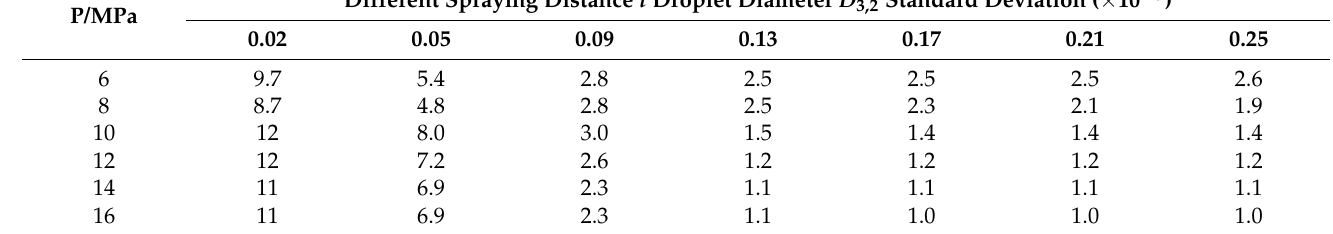
Table 5. Standard deviation of droplet diameter.